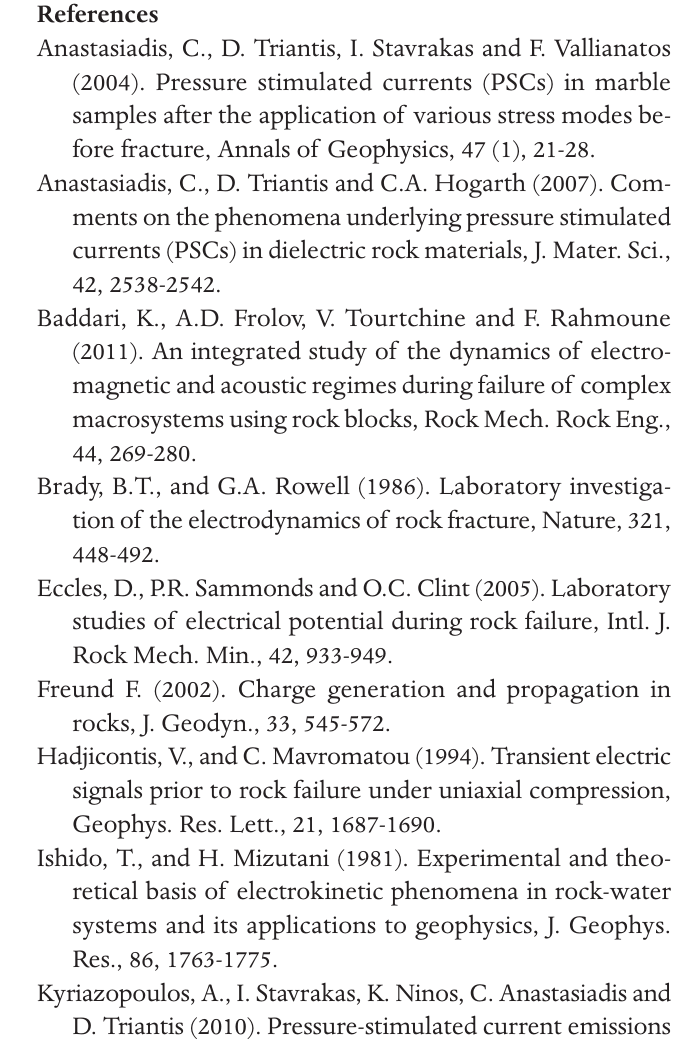
Figure 5. Recording (a): PSC excitation when the amphibolite sample was under high levels of mechanical stress close to fracture ( v Recording (b): The corresponding behavior of the mechanical strain of the sample. The PSC excitation appears to be directly related to the corresponding abrupt increase in the